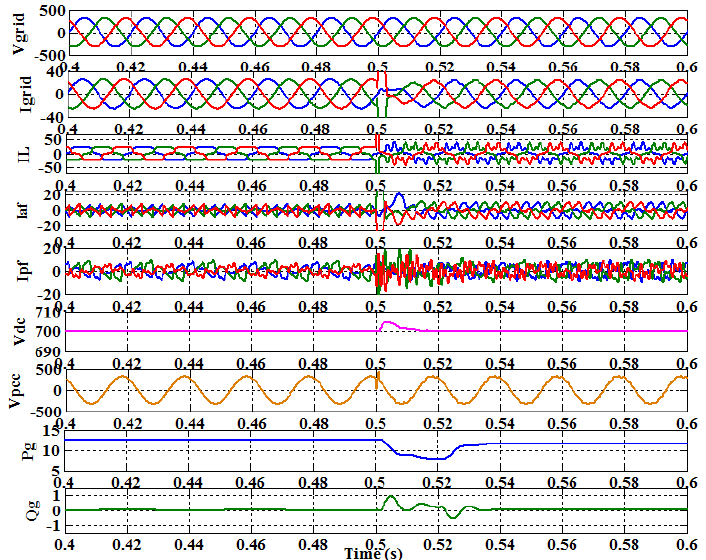
Figure 8. Grid voltage and current, Load current, Injected active filter current, Injected passive filter current, DC link voltage, PCC voltage, Active and Reactive power drawn from the grid by the load connected at PCC of the system when switching from inductive to capacitive load in grid-connected mode.